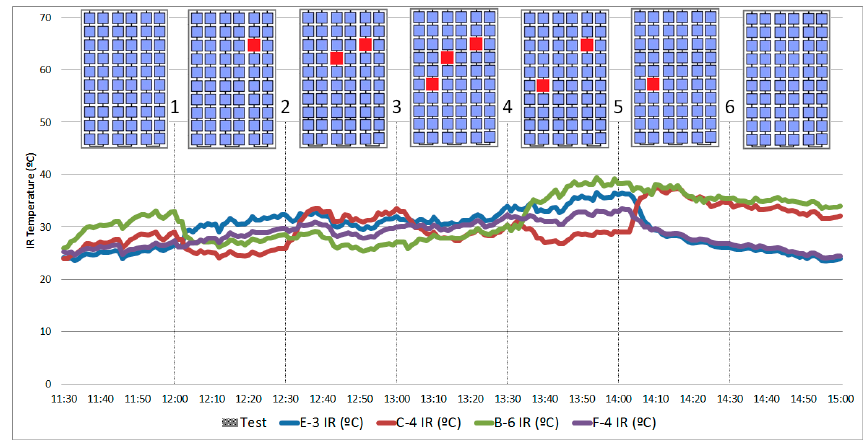
Figure 15. IR thermographic camera temperatures on the front side of the PV module in test 3.